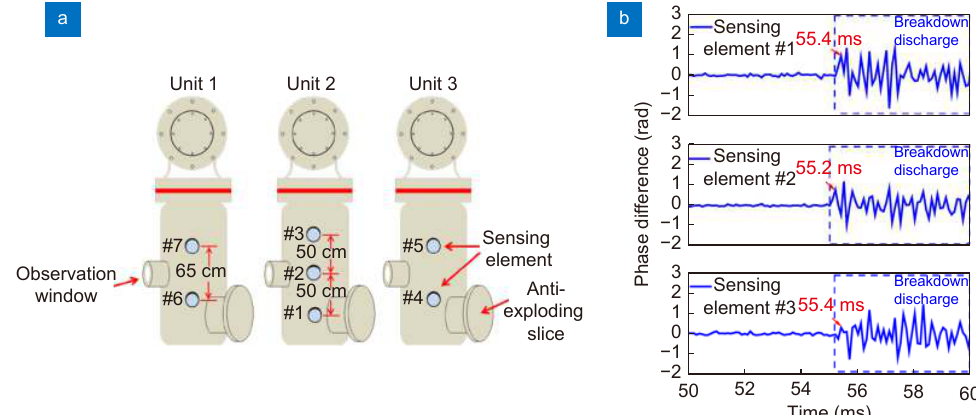
Fig. 14 | ( a ) Fiber coil transducer deployment on the GIS device. ( b ) Detected discharge signal of transducer #1, #2 and #3 at pulse repetition rate of 10 kHz. Figure reproduced from ref. 121 , under a Creative Commons Attribution 4.0 International